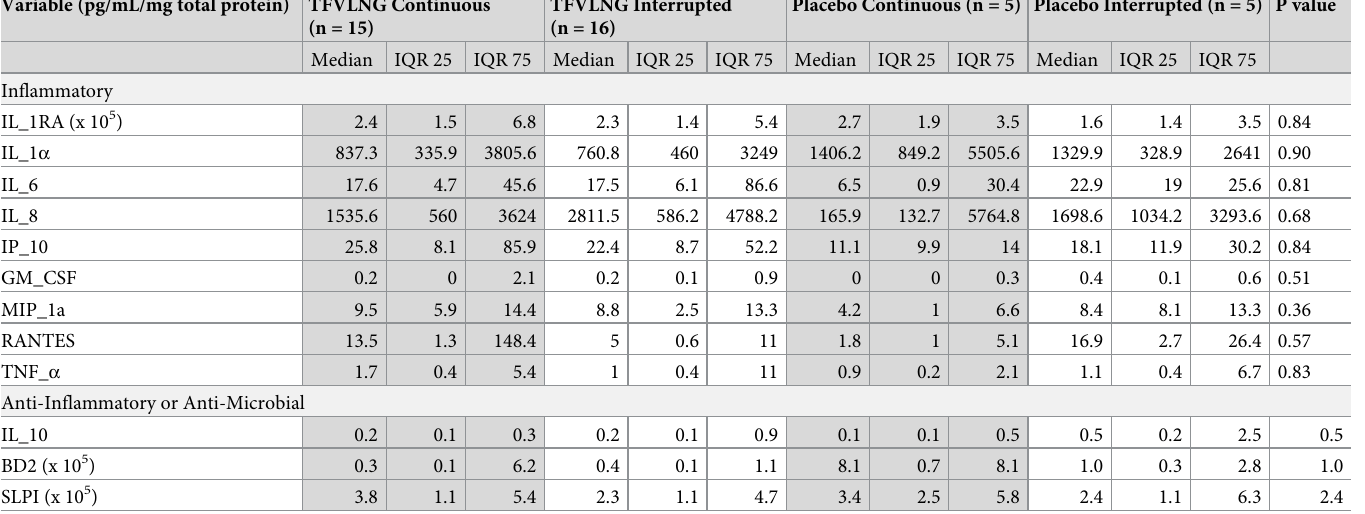
Table 4. Comparison of independent group soluble proteins at end of